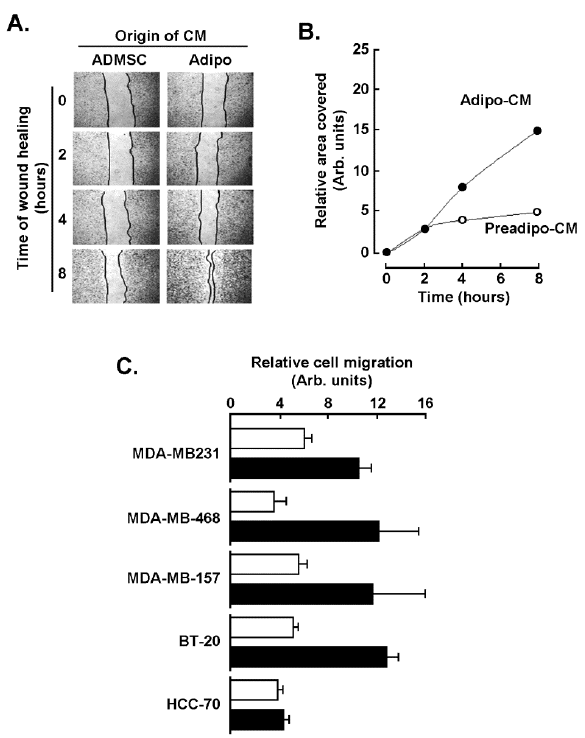
Figure 3. Chemotaxis response of different TNBC-derived cell lines to adipocytes secretome. ( A ) A wound-healing assay was performed with MDA-MB-231 cells in response to conditioned media isolated from ADMSC (Preadipo-CM) and from adipocyte conditioned media (Adipo-CM), and pictures were taken of the recovered area as described in the Methods section. ( B ) The extent of the recovered area was calculated from a representative experiment. ( C ) Chemotaxis screening of four other human TNBC-derived cell lines was performed with MDA-MB-468, MDA-MB-157, BT-20, and HCC-70 cells in response to either Preadipo-CM (white bars) or Adipo-CM (black bars). Two independent cell migration assays were performed and measured in triplicate.